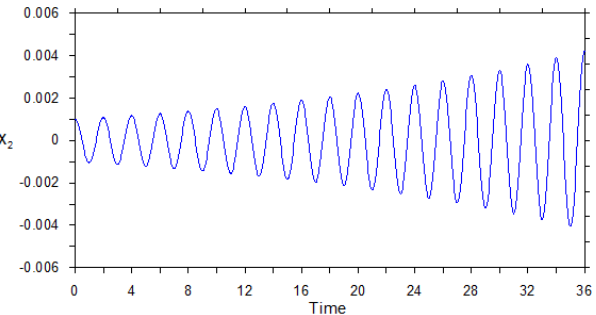
Fig. 6. Time evolution of the solution of Eq. (12) obtained for pa- rameter β 0 slightly less than the threshold